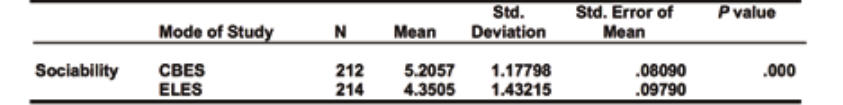
Table 7: Comparison of sociability between the Groups